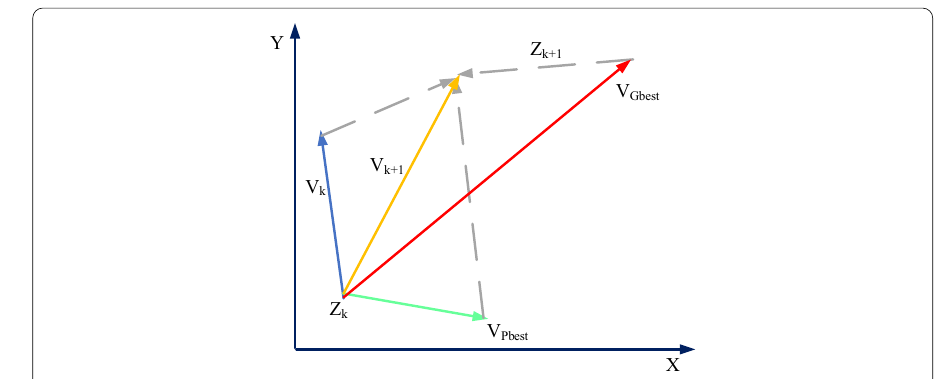
Fig. 8 Vector diagram of motion and position of particle